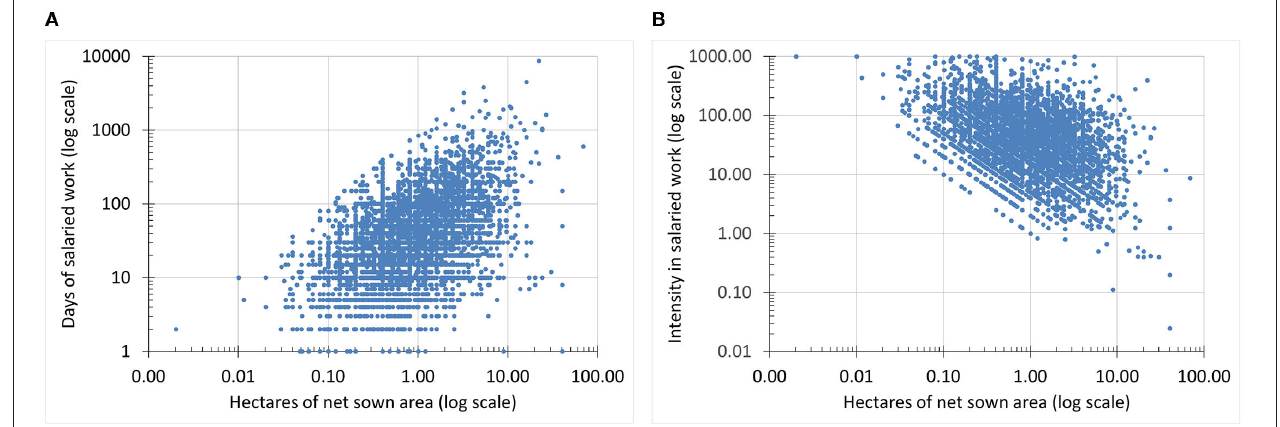
FIGURE 5 | Relationships between farm size and salaried work. (A) The more the size increases, the more employees there are per farm (B) but the more the size increases, the fewer employees there are per hectare Source: B. Dorin, based on IHDS-II and Dorin et al. (2019). Note: Of the 42,152 households surveyed by the India Human Development Survey II (IHDS survey 2011–12), 16,475 have a net sown area greater than zero, those shown in the graph after removing a few outliers (66